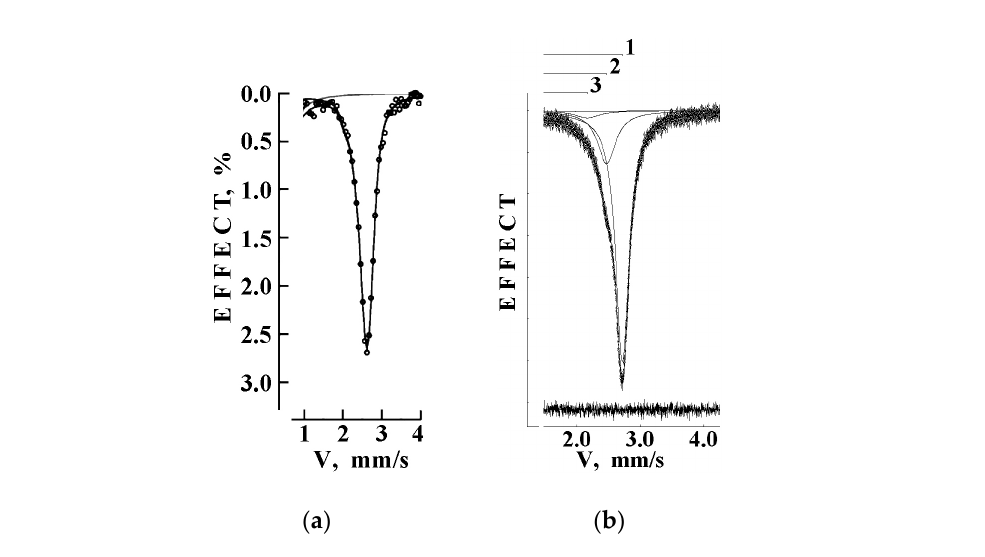
Figure 2. Comparison of the line shapes of the most positive peak in the Mössbauer spectra of Fe‑ gluconate in Ascofer ® measured in 128 channels ( a ) and in 4096 channels (the differential spectrum is shown on the bottom) ( b ). Adapted from Ref. [31]. (Reproduced from “Mössbauer spec ‐ troscopy with a high velocity resolution: Principles and applications”, M.I. Oshtrakh and V.A. Semionkin; AIP Conference Proceedings 1781 , 020019 (2016), with the permission of AIP Publish ‐ ing.)